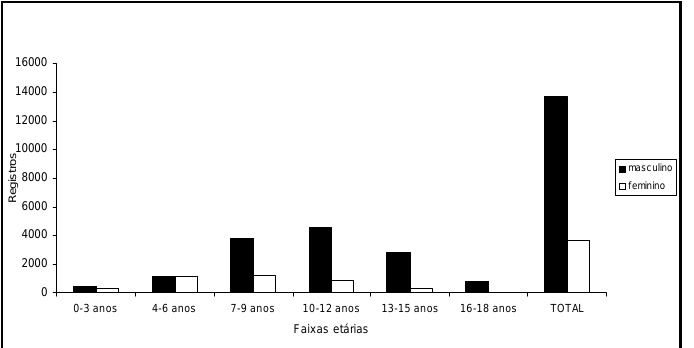
Figura 1 . Frequência de registros de crianças por idade e sexo.